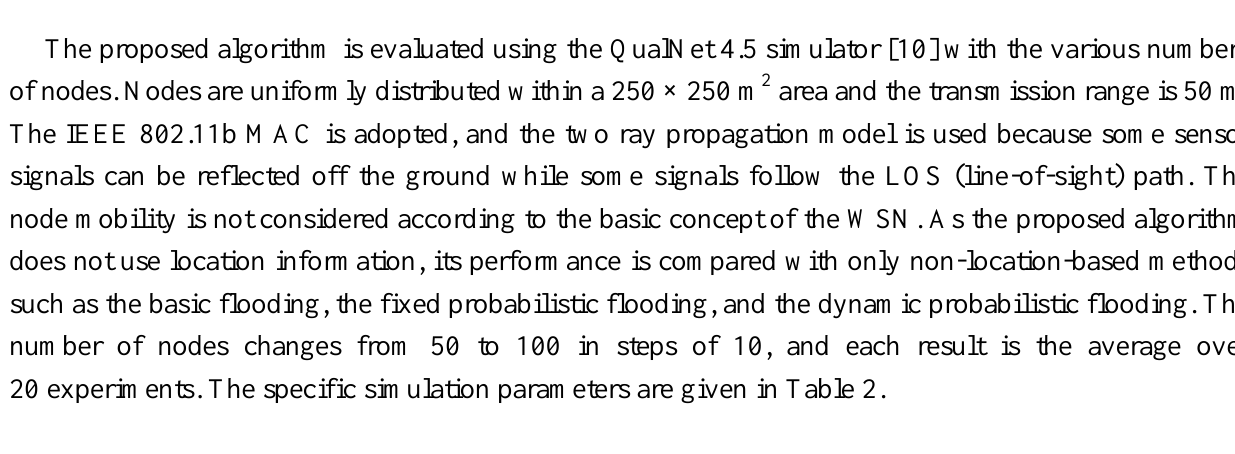
Table 2. Simulation